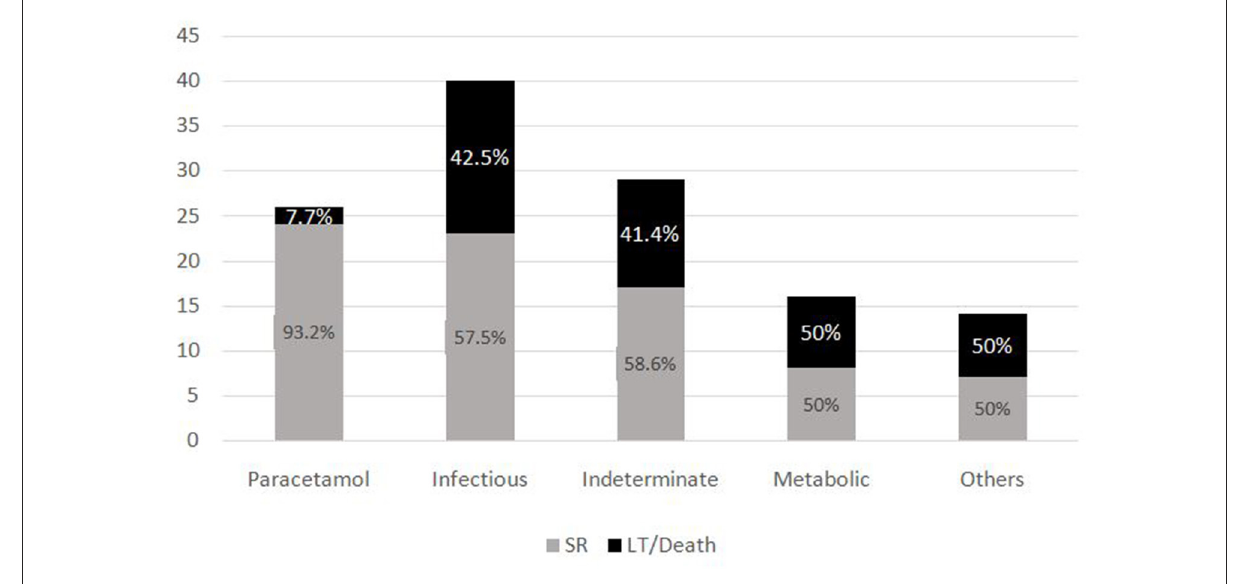
FIGURE2 Outcome of patients based on etiologies.